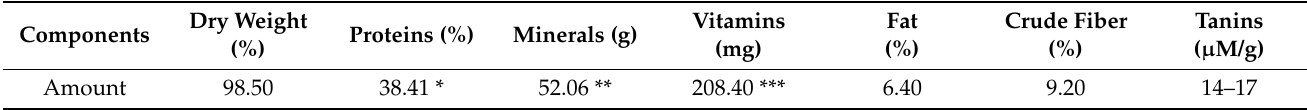
Table 7. Average chemical composition per 1 kg of EPC.